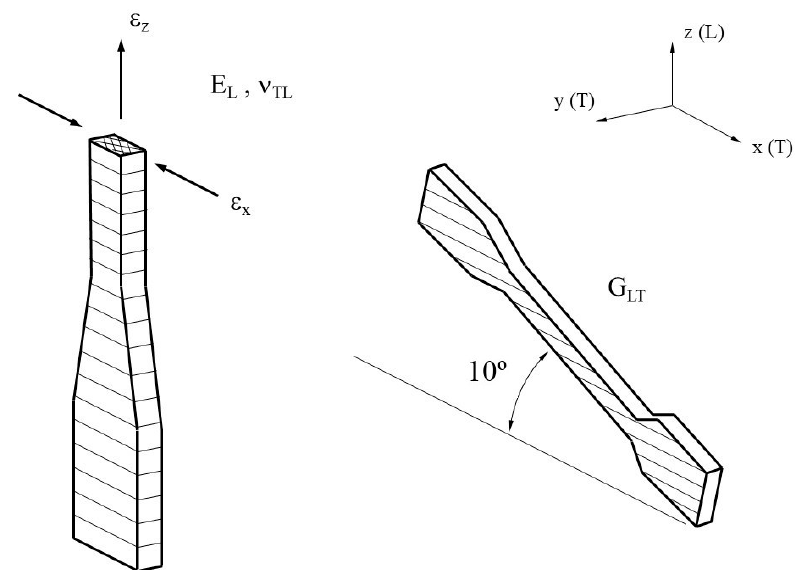
Figure 6. Configuration of tensile specimen on vertical and 10° configuration to determine Ez, ν TL , and G LT.